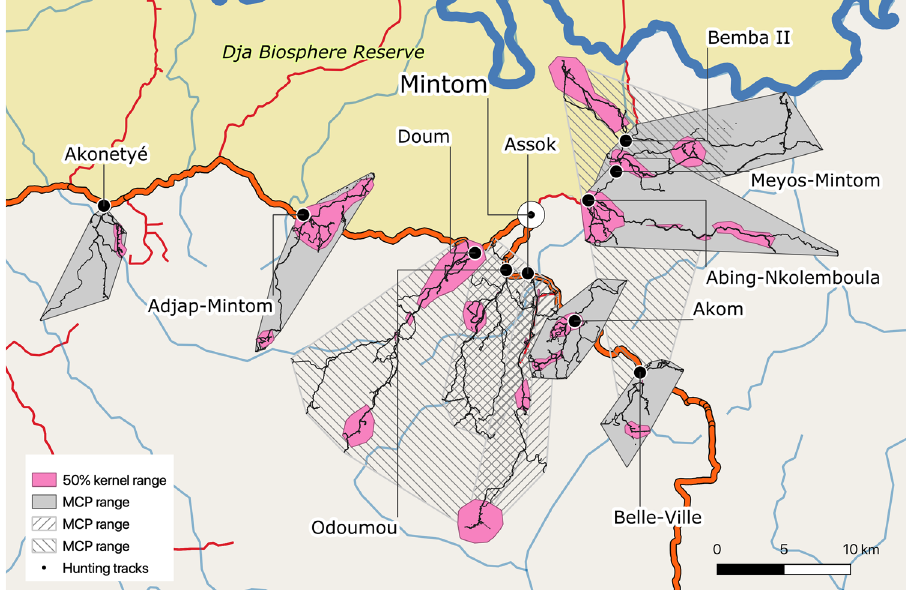
Figure 3. Hunting tracks, MCP home ranges and 50% kernel utilization distributions for hunters in the 10 Baka study villages in southeastern Cameroon (295 tracks recorded for 51 hunters). The background map was created using QGIS version 3.16.0-Hannover (https ://qgis.org/en/site/) from public domain map datasets from Open Street Map (www.opens treet map.org), diva-gis (diva-gis.org) and Natural Earth (http://www.natur alear thdat a.com) and the published map of the Dja Biosphere Reserve 89